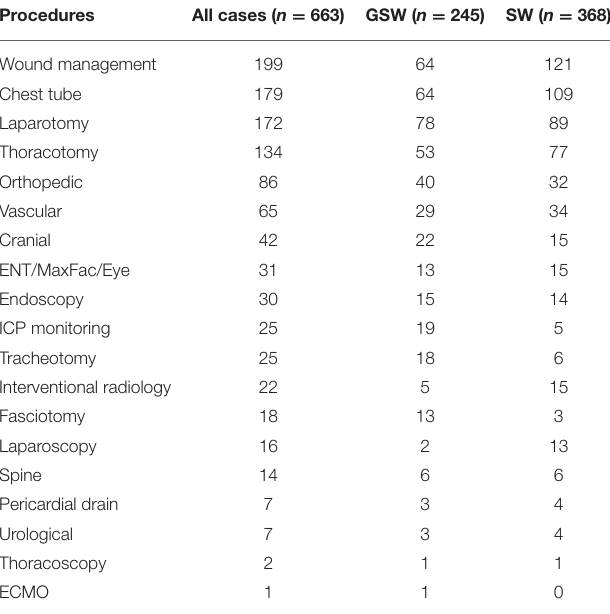
TABLE 3 | Emergency procedures on admission. Procedures